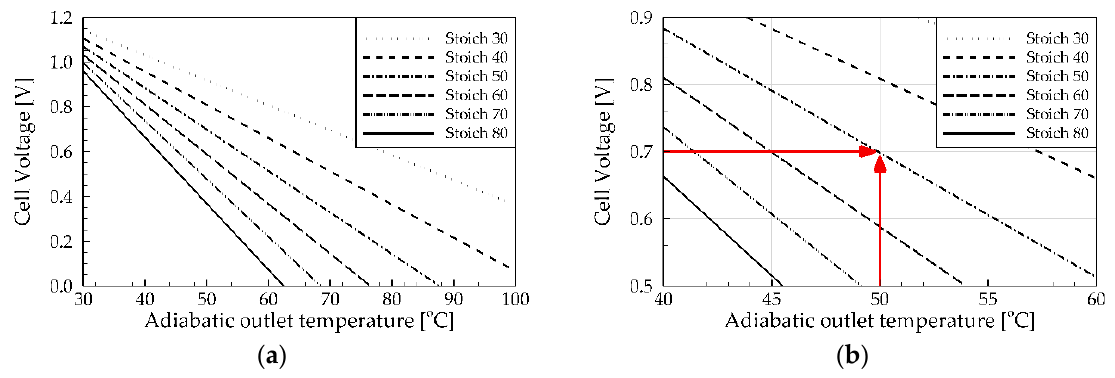
Figure 4. Dependency of the adiabatic outlet temperatures of the product stream on the operating cell voltage. The incoming conditions were a temperature of 25 ° C and a relative humidity of 30%. ( a ) Entire voltage range, ( b ) close-up on the region of interest.